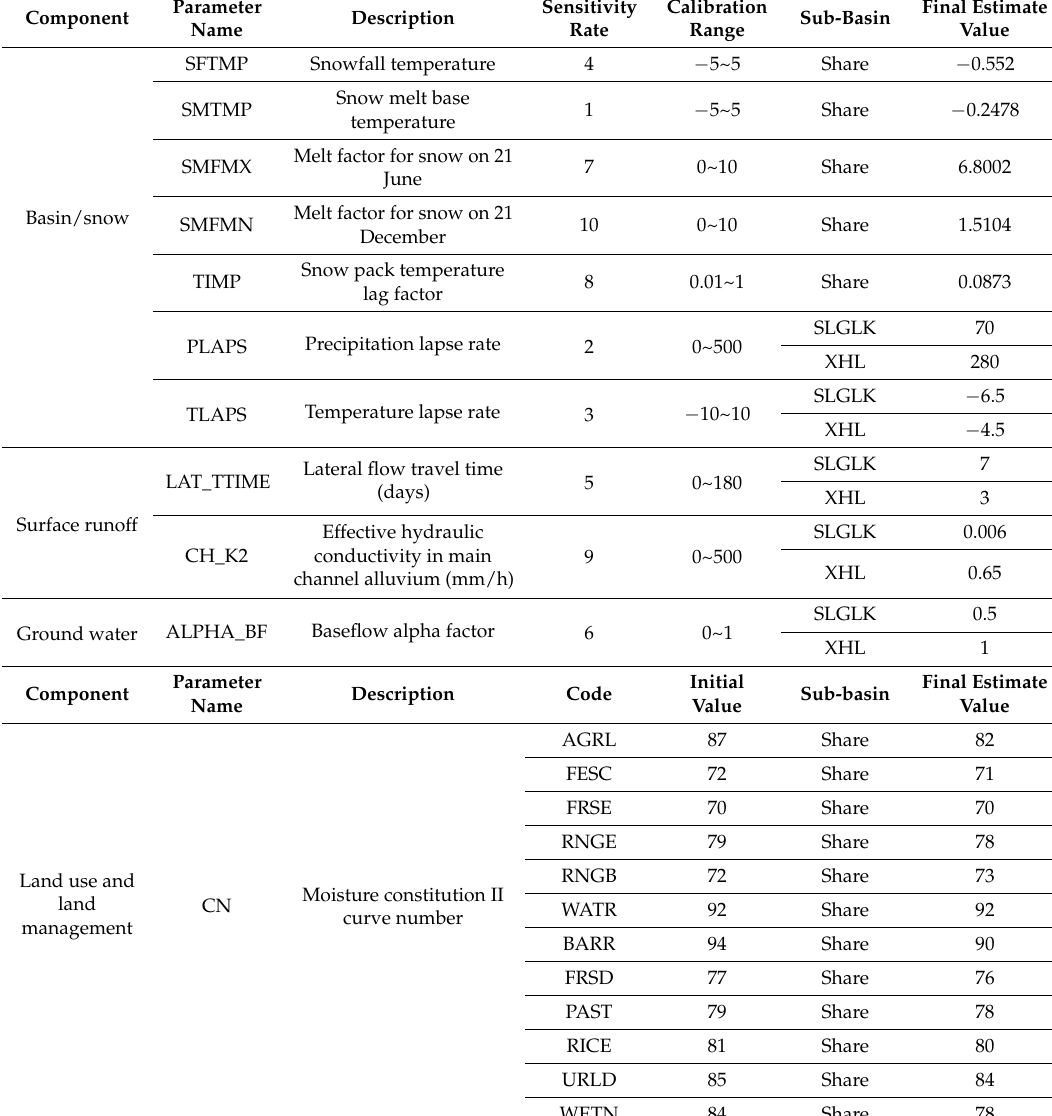
Table 2. Sensitivity rate, calibration range, initial value, sub-basin and final calibration estimate value of top ten selected SWAT model